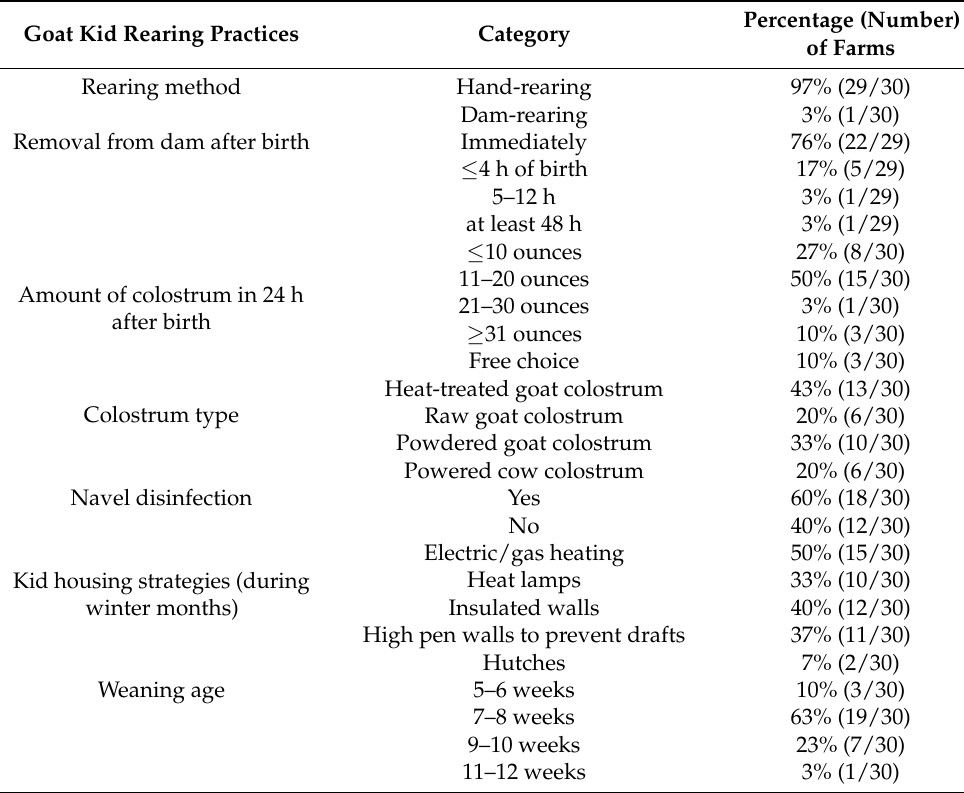
Table 6. Dairy goat producer responses relating to common kid rearing